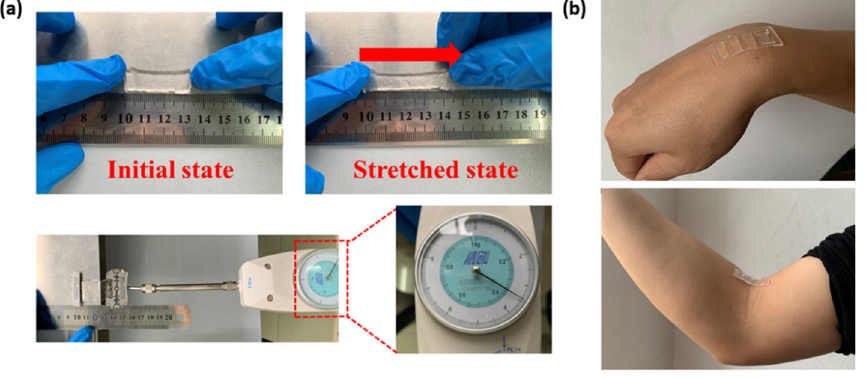
Figure 4. Performance test of the flexible hydrogel biosensor. ( a ) Tensile test. ( b ) Biosensor– epidermis adhesion.